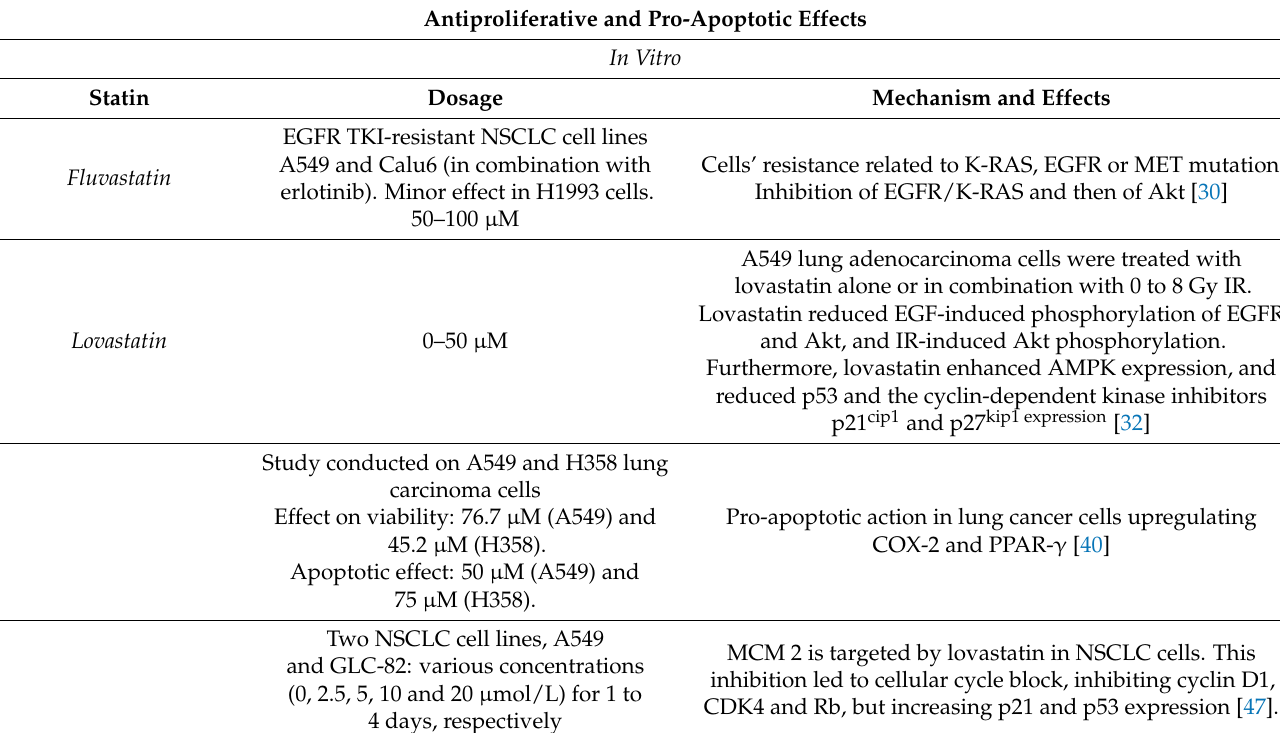
Table 3. Statins’ antiproliferative and pro-apoptotic effects in lung